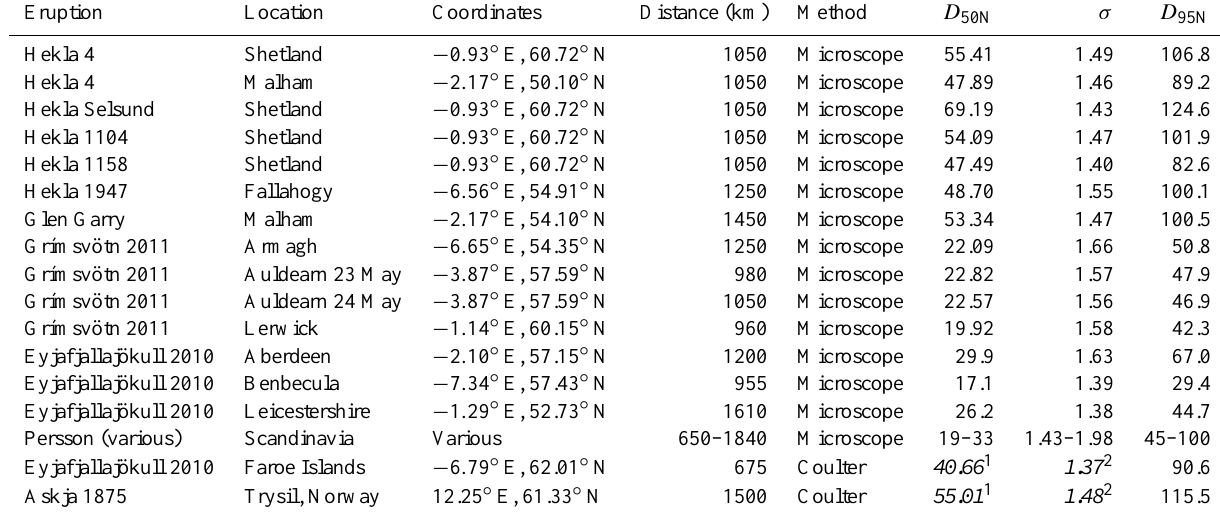
Table 2. Grain-size distribution parameters for distal cryptotephra. D 50N is the median number diameter (µm), σ is the geometric standard deviation of the lognormal number distribution of grain length, except for two Eyjafjallajökull 2010 and Askja 1875 laser particle sizer examples, which are better fitted by a Weibull distribution, whose parameters are given in this case (italics). 95% of the particles have length of less than D 95N (µm). Data from Persson (1971) are also summarised.